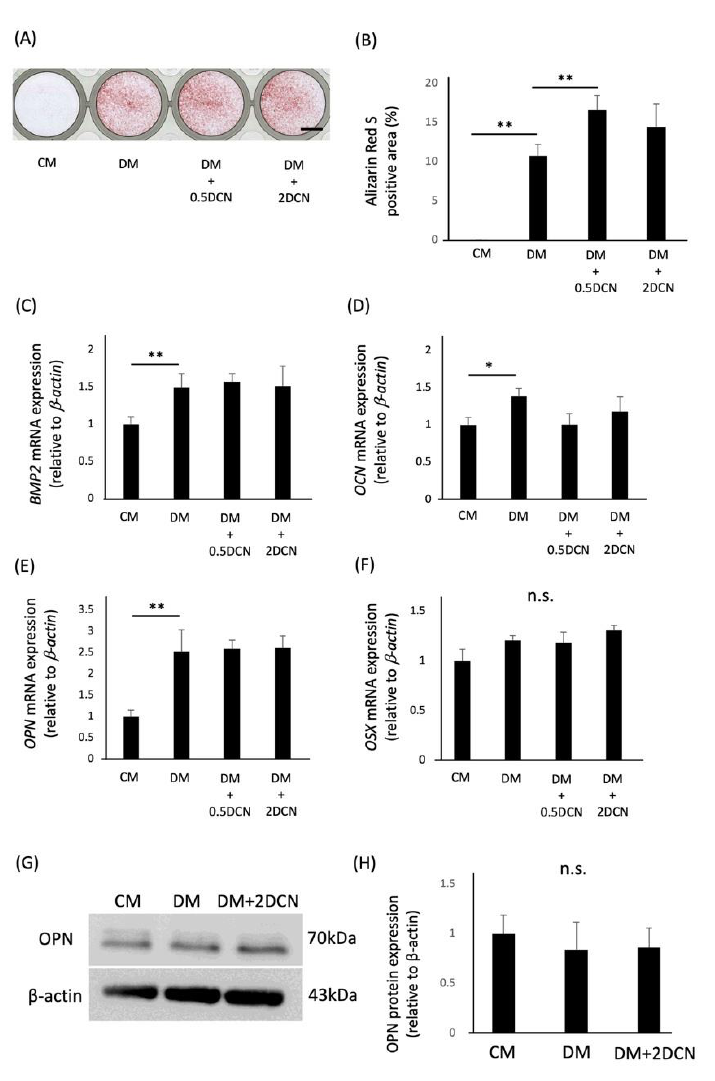
Figure 3. Effects of DCN on the osteoblastic differentiation of preosteoblasts. ( A ) Preosteoblasts were cultured in 10% FBS/ α -MEM (CM), CM with 1.5 mM CaCl 2 (DM), DM on a 0.5 µ g/mL DCN coating (DM + 0.5 DCN), or DM on a 2 µ g/mL DCN coating (DM + 2 DCN) for 12 days. Alizarin red S